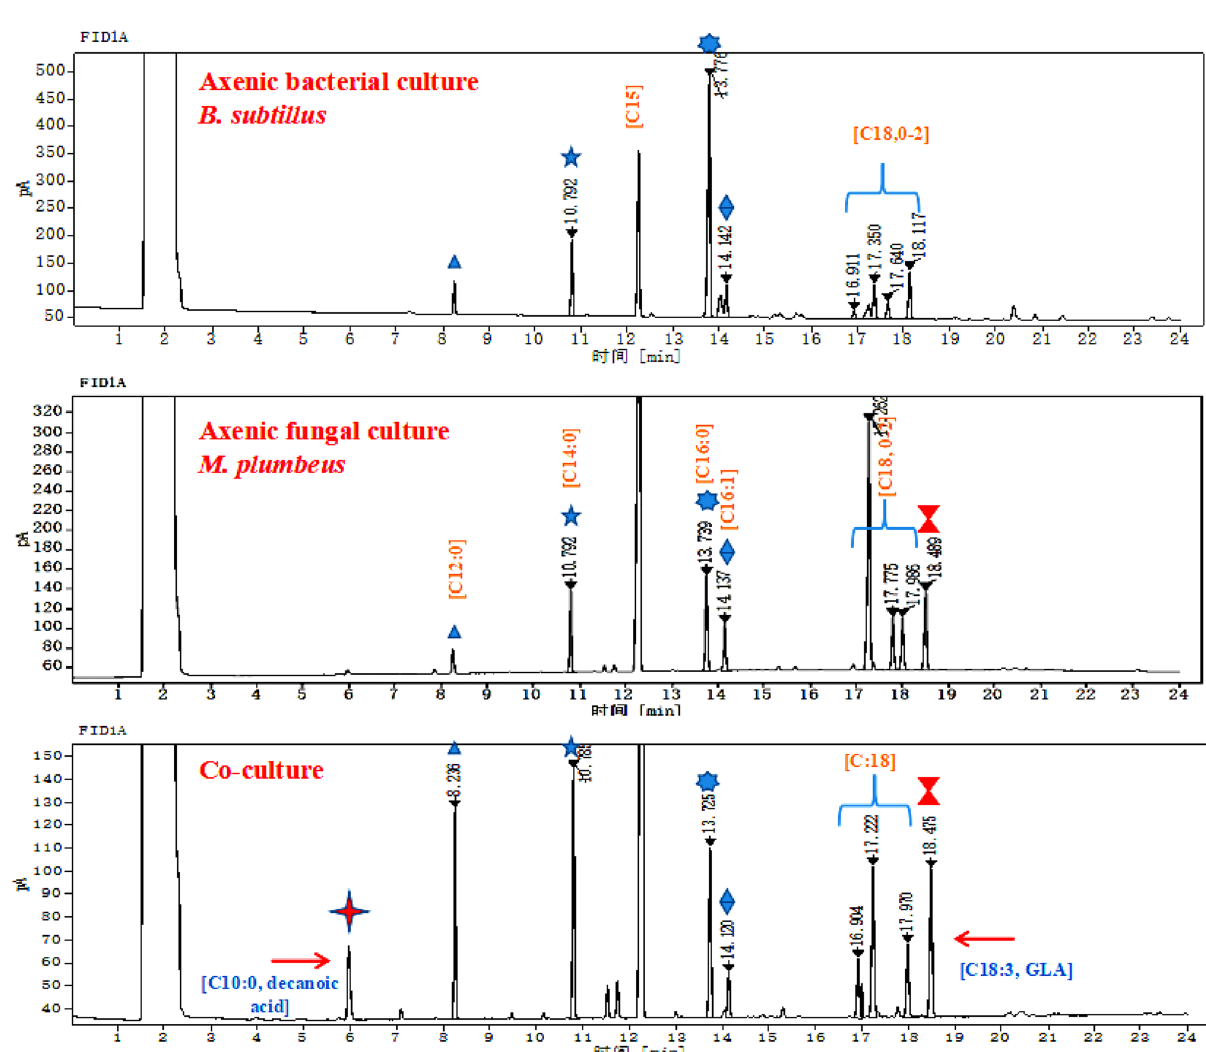
Figure 8. The GC chromatograms of FAs from axenic and cocultures of M. plumbeus and B. subtilis after 6 days of fermentation. Note that C10:0 is an induced